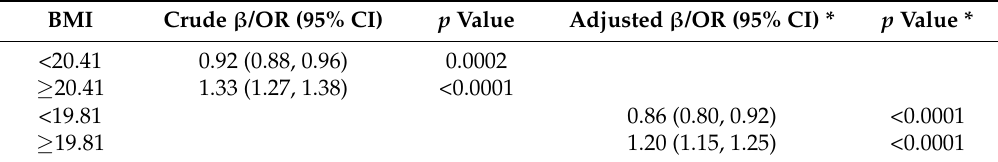
Table 4. Threshold effect analysis of BMI on VI.